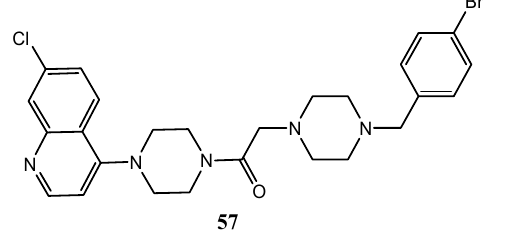
Figure 30. Structure of the quinoline VEGFR-2 inhibitor 56 [133].